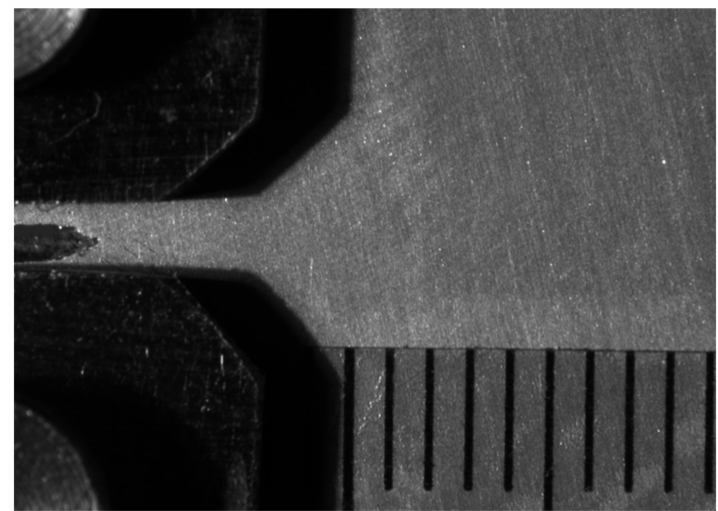
Figure 18. Crack image calibration method.